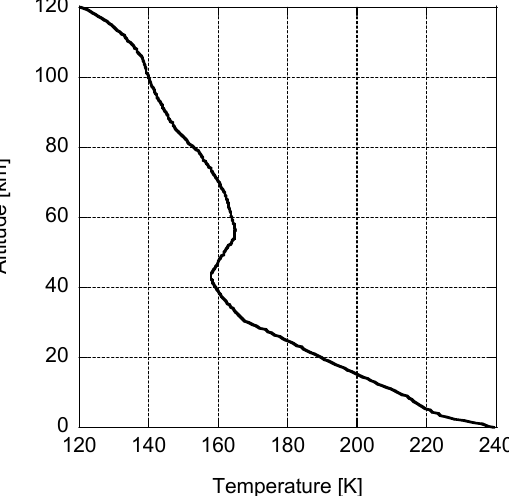
Figure 3. Martian atmospheric temperature with respect to altitude, adapted from [17].